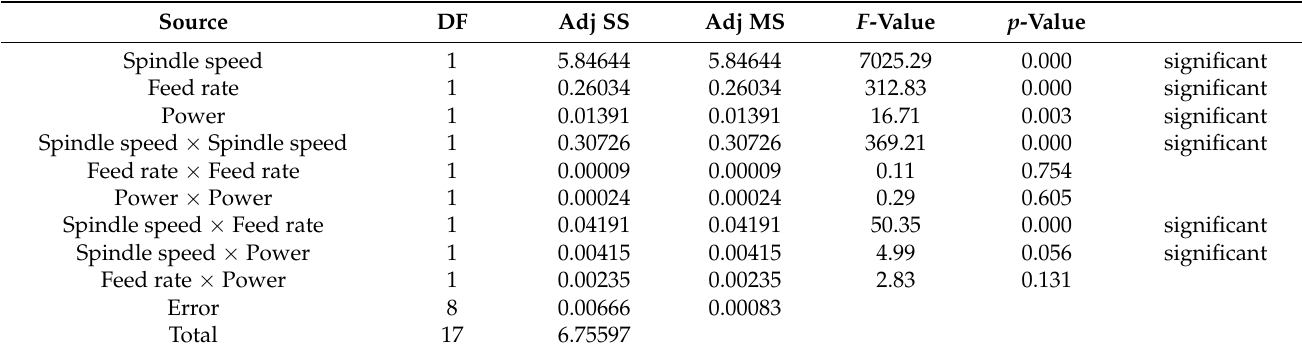
Table 11. ANOVA results for the flank wear width with conventional cutting